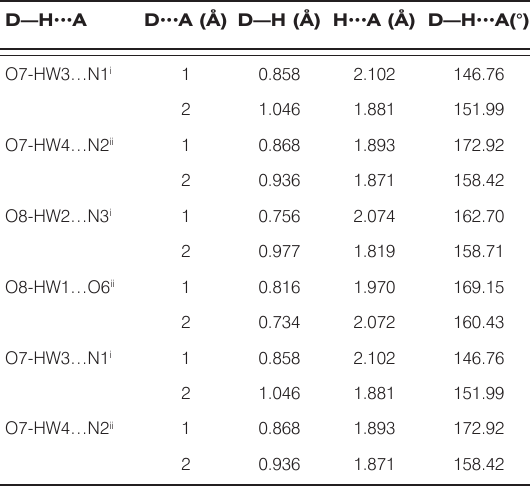
Table 3. Geometrical parameters of intermolecular hydrogen bonds in 1 and 2 .